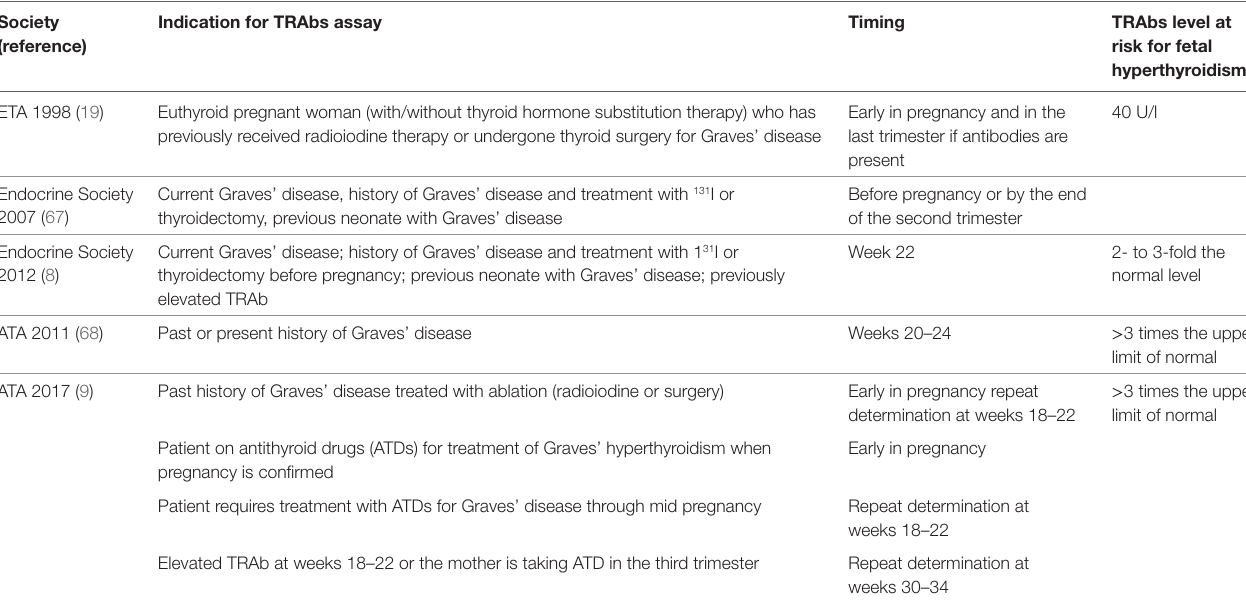
TAble 2 | Indications and timing for TSH receptor antibody (TRAb) assays in pregnancy according to